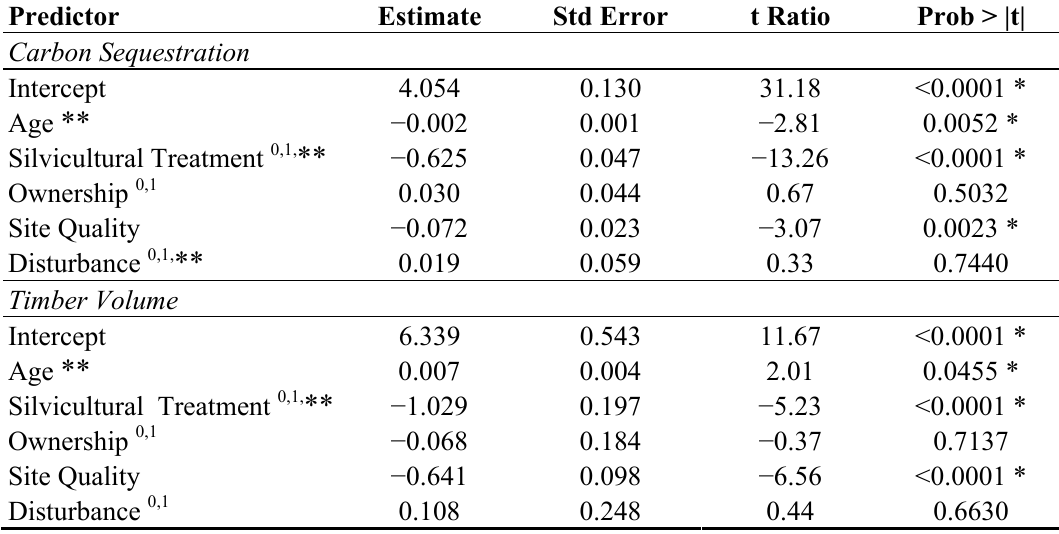
Table 4. Parameter estimates of the predictors of net carbon sequestration, timber volume, and water yield in Florida Pinus elliotti